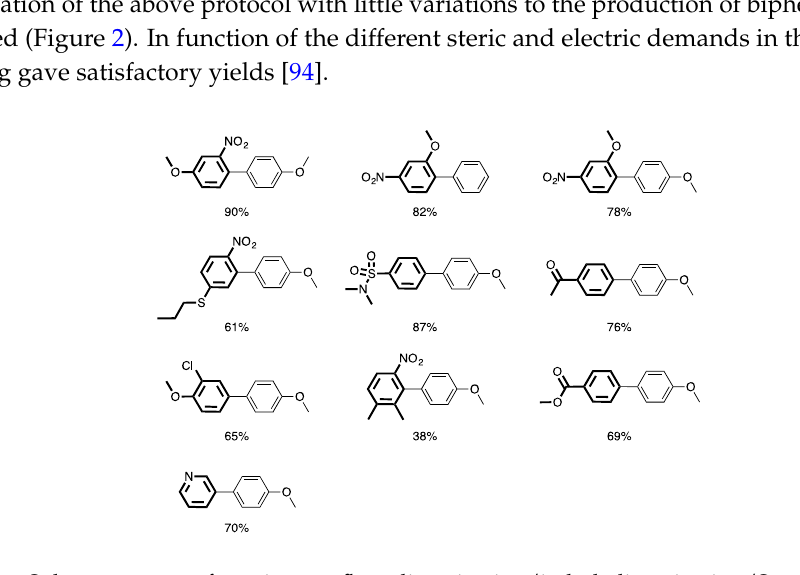
Figure 2. Substrate scope of continuous flow diazotization/iododediazotization/Suzuki–Miyaura cross-coupling sequence starting from aniline